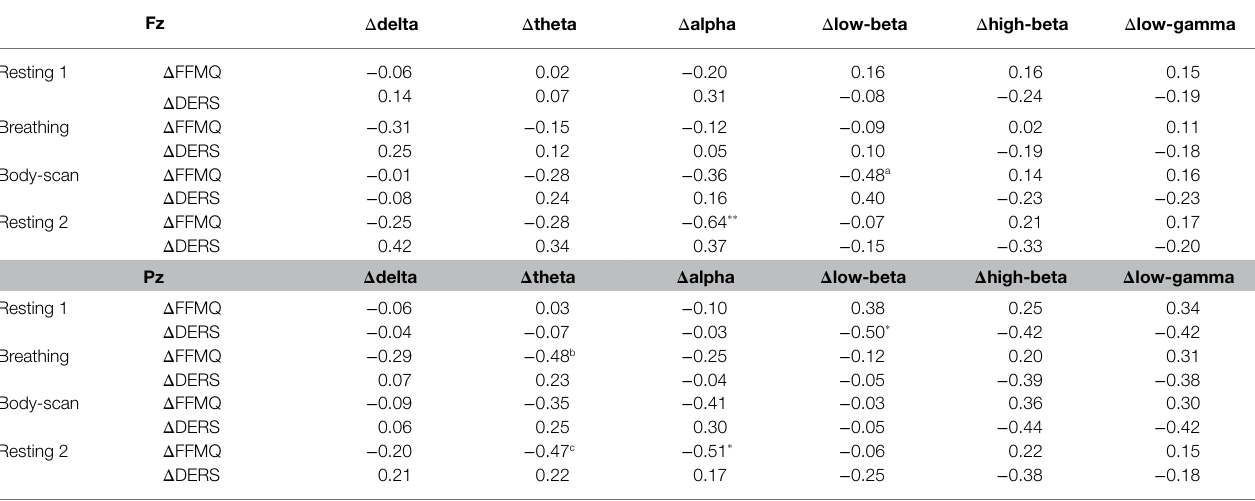
TABLE 2 | Correlation coefficients among the changes of EEG wave bands and behavioral measures in MBSR group. Fz Δ delta Δ theta Δ alpha Δ